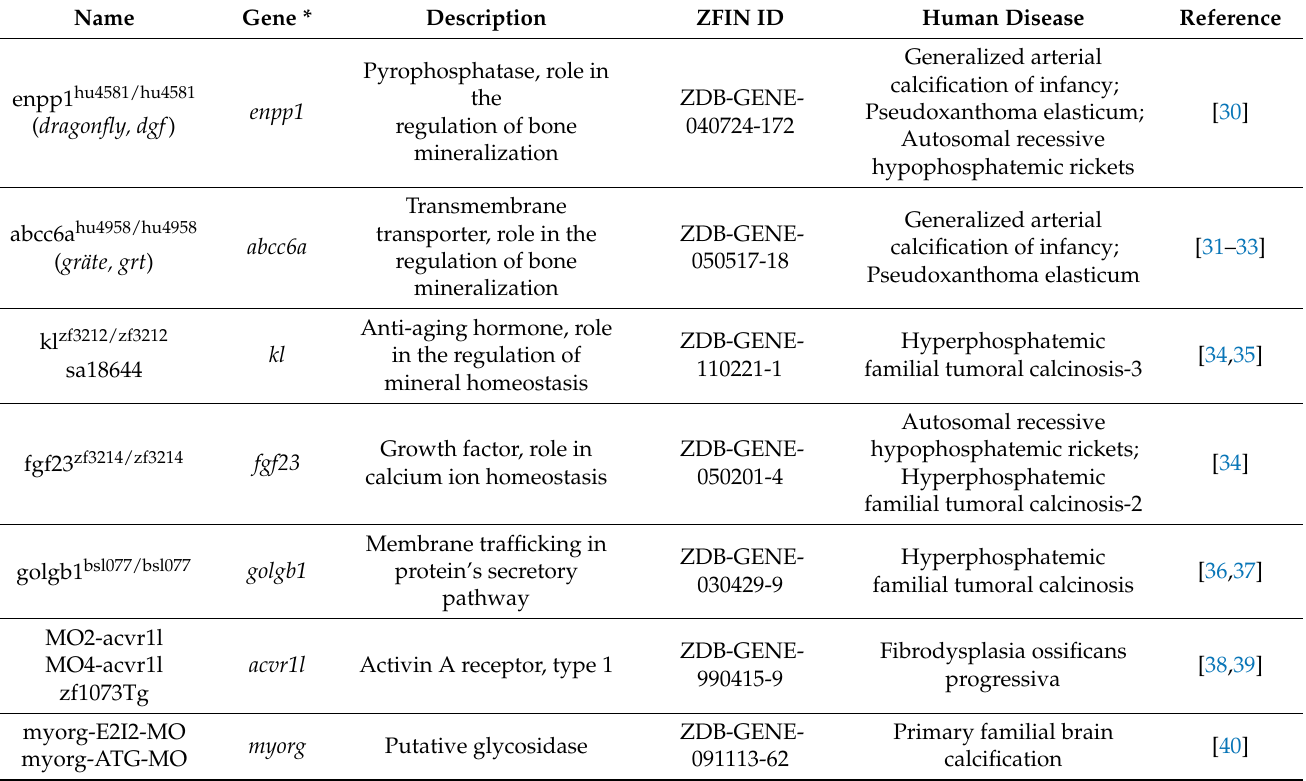
Table 1. Zebrafish mutants to study ectopic mineralization